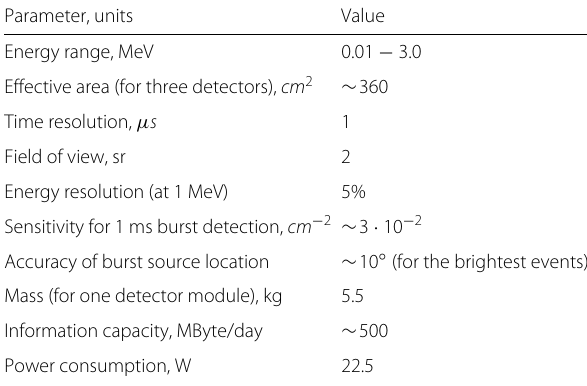
Table 3 GFM detector units’ parameters Parameter, units Value Energy range,